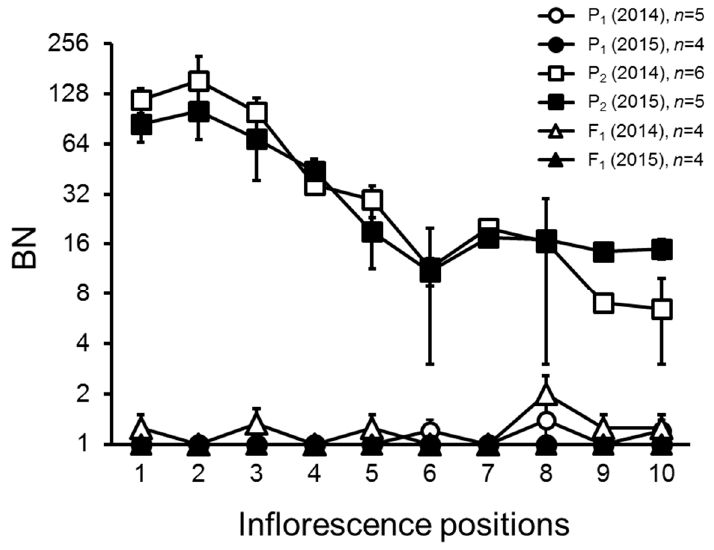
Figure 2. Effects of the inflorescence position and different growing seasons on the variation of BN in the F 1 , PI124039, and 10AS111A lines. Values are given as mean ± SD. P 1 : Solanum pimpinellifolium PI124039; P 2 : S. lycopersicum 10AS111A; F 1 : the F 1 is derived from P 1 and P 2 .